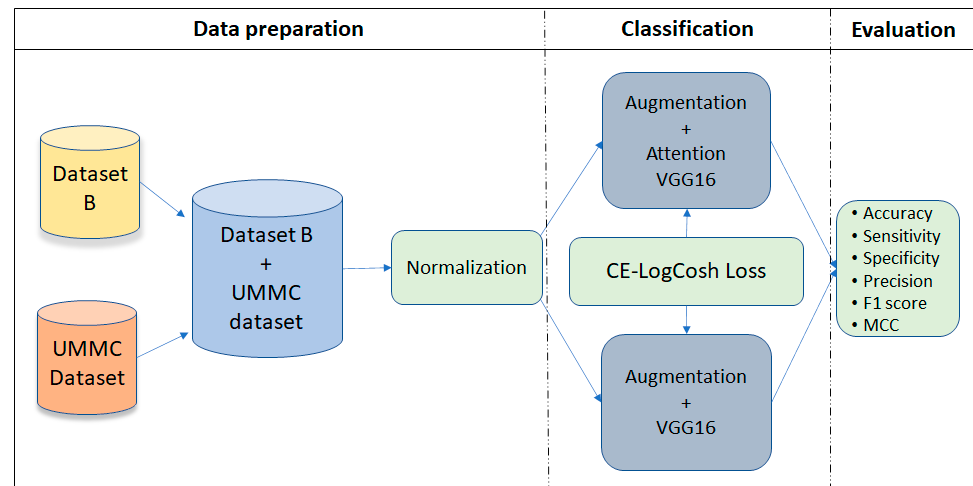
Figure 1. The overall framework of the proposed study. This splits into three phases: data preparation, lesion classification and evaluation. In data preparation, the two ultrasound image datasets (i.e., Dataset B and UMMC) were integrated and normalization. Classification step involves the proposed Attention-VGG16 model with CE-LogCosh loss function, which was then compared using the standard pre-trained VGG16 network. Finally, the classification performance was measured according to the six evaluation metrics.